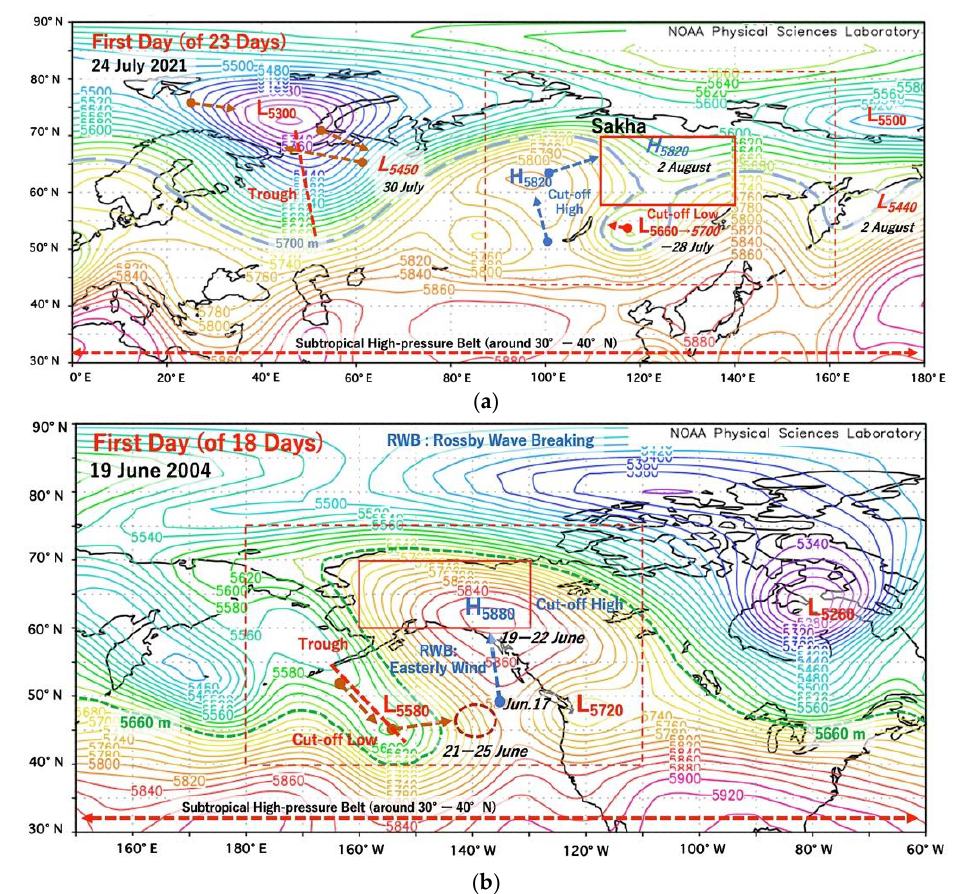
Figure 5. Large westerly meandering (LWM) and omega block (one COH and two COLs). ( a ) Sakha on 24 July. The study region is shown by the rectangle with the red line. The rectangle with the red dotted line shows the area to discuss fire weather. ( b ) Alaska+ on 19 June. The study region is shown by the rectangle with the red line. The rectangle with the red dotted line shows the area to discuss fire weather. RWB occurred under easterly winds.